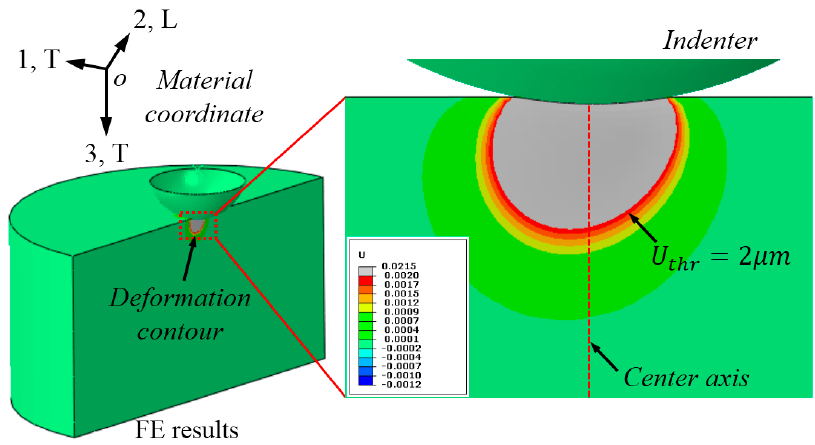
Figure 5. Out-of-plane deformation contour persisting on the cross-section after unloading.